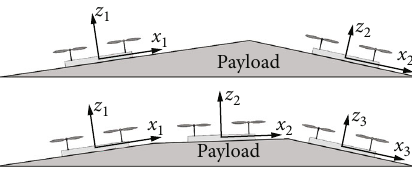
Figure 1: Payload